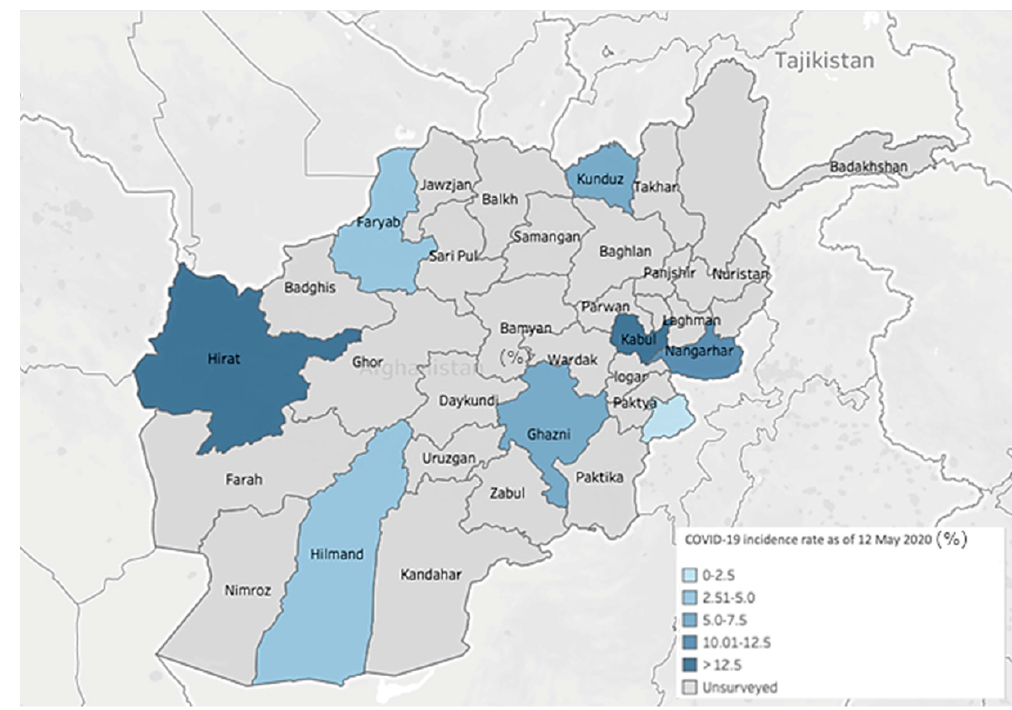
Figure 1. Cumulative incidence of COVID-19 in the surveyed regions-Afghanistan, as of 12 May Figure 1: Cumulative incidence of COVID-19 in the surveyed regions-Afghanistan, as of May